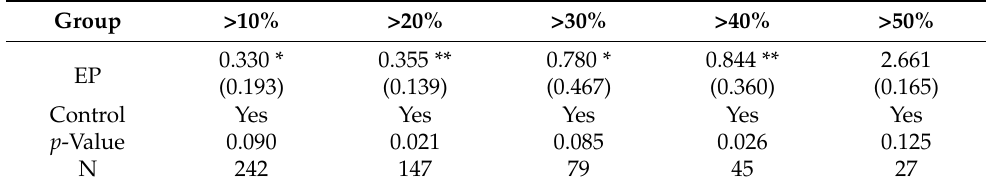
Table 6. Impact of EP on profit